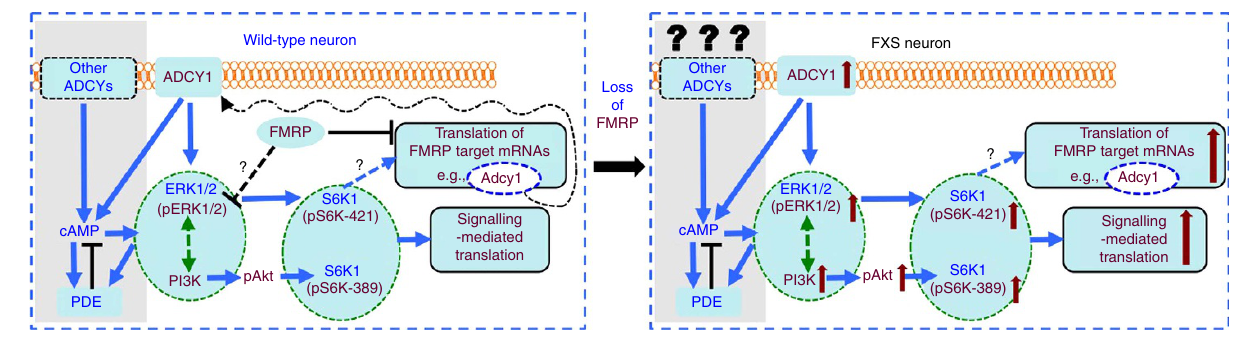
Figure 7 | Function of ADCY1 in connecting FMRP-regulated translation and exaggerated ERK1/2–S6K1 signalling in FXS. Signalling molecules affected in FXS, translation of direct FMRP mRNA targets (including Adcy1), and translation under control of Adcy1–ERK1/2 signalling are marked in maroon font. The loss of FMRP-dependent suppression of Adcy1 mRNA translation results in overexpression of ADCY1 on synaptic membrane, which leads to exaggerated ERK1/2 signalling (possibly cross talks with PI3K pathway), increased S6K1 activity and enhanced protein synthesis in FXS neurons. A possible feed forward loop, in which ADCY1-mediated ERK1/2 over-activation further enhances Adcy1 mRNA translation, may amplify exaggerated neuronal signalling and translation dysregulation in FXS. The homoeostasis of cAMP is maintained by the balance between multiple ADCYs and PDE, whose activity can be up-regulated by cAMP, ERK1/2 and PI3K. It is unclear whether the elevated ERK1/2 activity caused by ADCY1 overexpression is solely mediated by cAMP production. Insights about how FMRP-dependent translation impinges on the feedback network among these signalling molecules require further